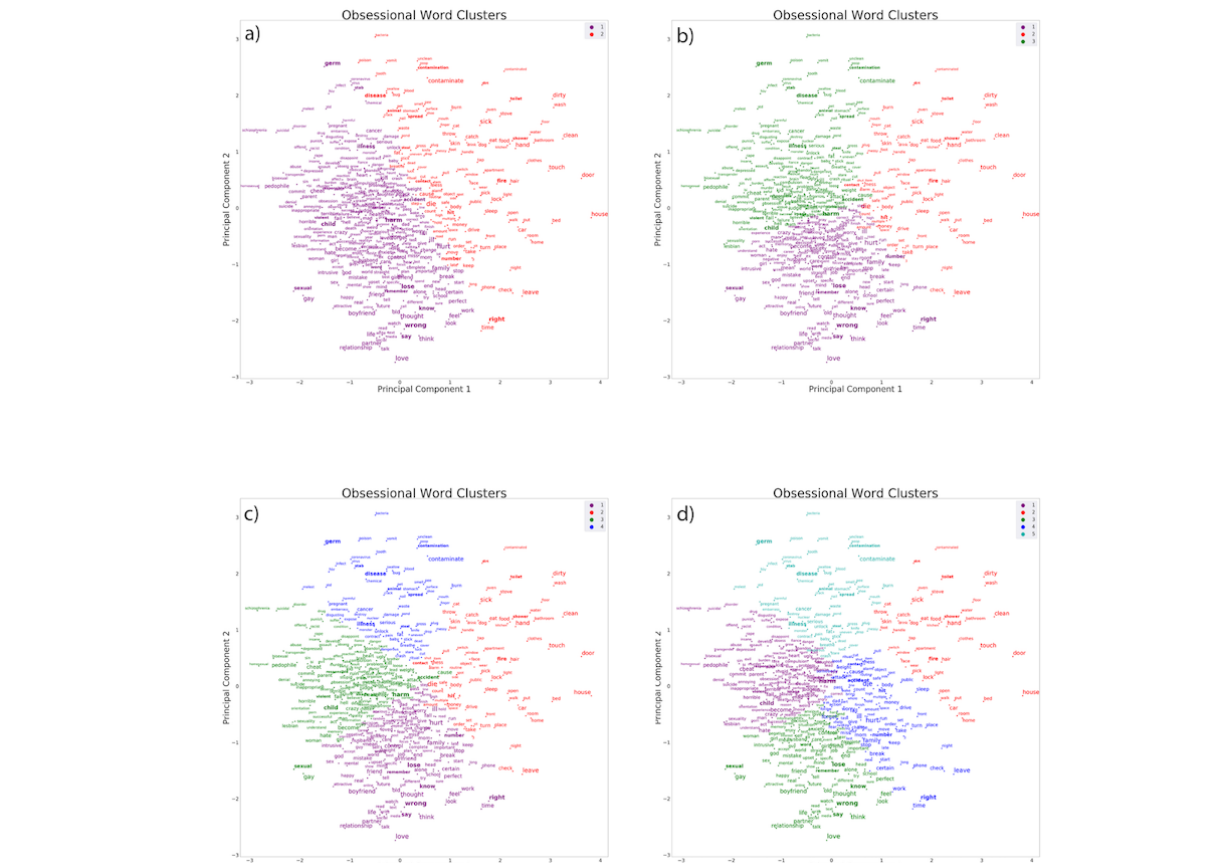
Figure 3. Frequently occurring obsessional words and their clustering, based on semantic relationships. The word embedding was trained on the entirety of the data set and clustered with k values of 2, 3, 4, and 5. The font is scaled according to the frequency of occurrence of each word. For reference, bolded words are those that also appear in the Yale-Brown Obsessive-Compulsive Scale Symptom Checklist. Observations of how the bolded words change clusters as k values change provide valuable insight into the similarities of OCD